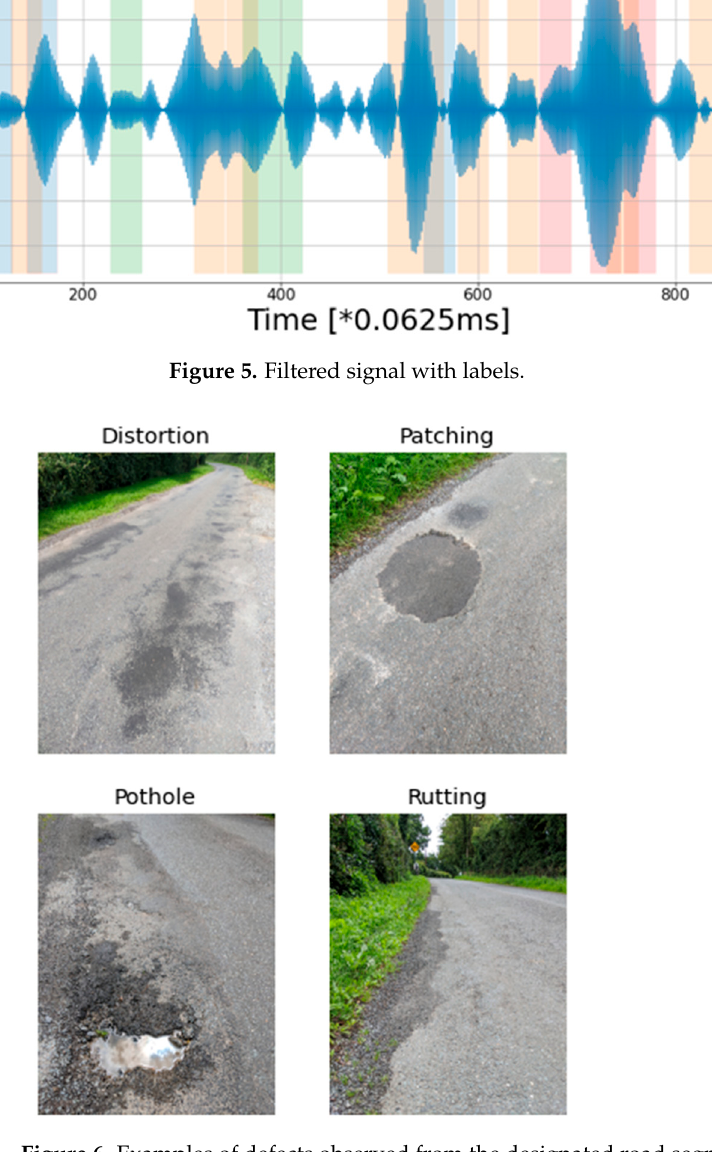
Figure 6. Examples of defects observed from the designated road segment.